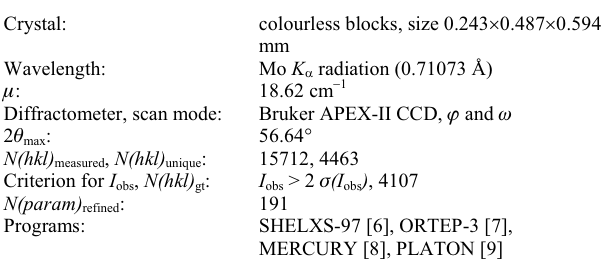
Table 1. Data collection and handling.